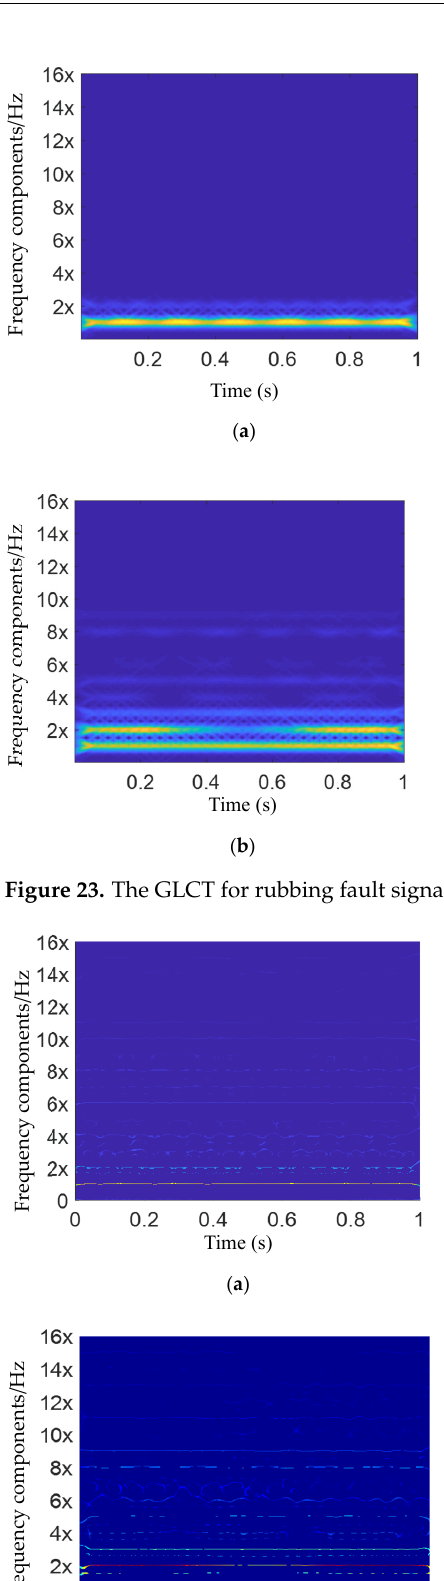
Figure 22. Spectrum diagram of rubbing fault. ( a ) Slight rubbing ( b ) Serious rubbing The 1600 Hz sampling frequency and 128 window width is taken to perform the GLCT, SET and RSECT for the signal of slight rubbing and serious rubbing, respectively. The cor- responding time–frequency distribution of the three methods are shown in Figures 23–25.